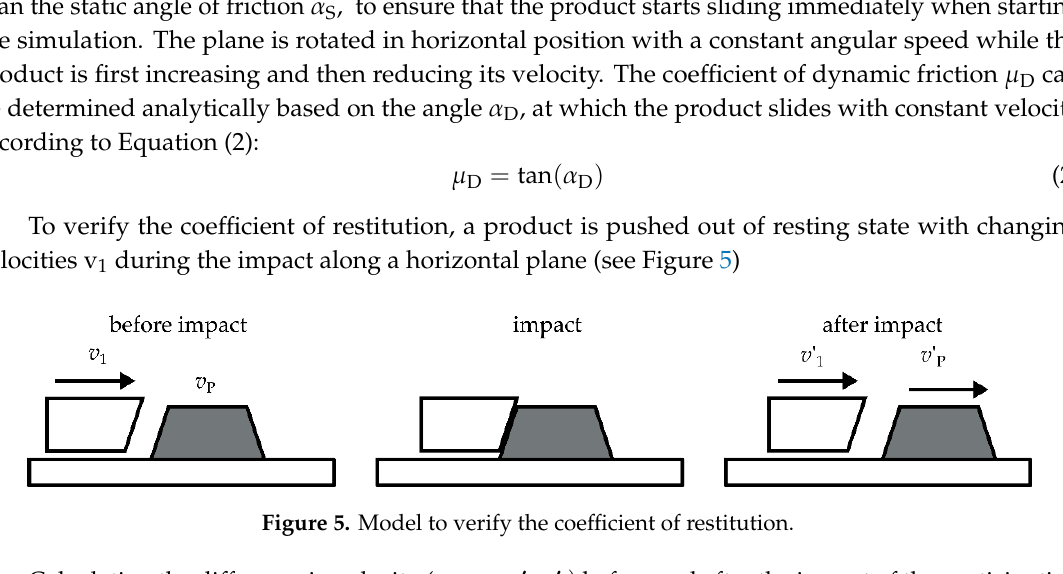
Figure 4. Inclined plane to verify the coefficient of friction.